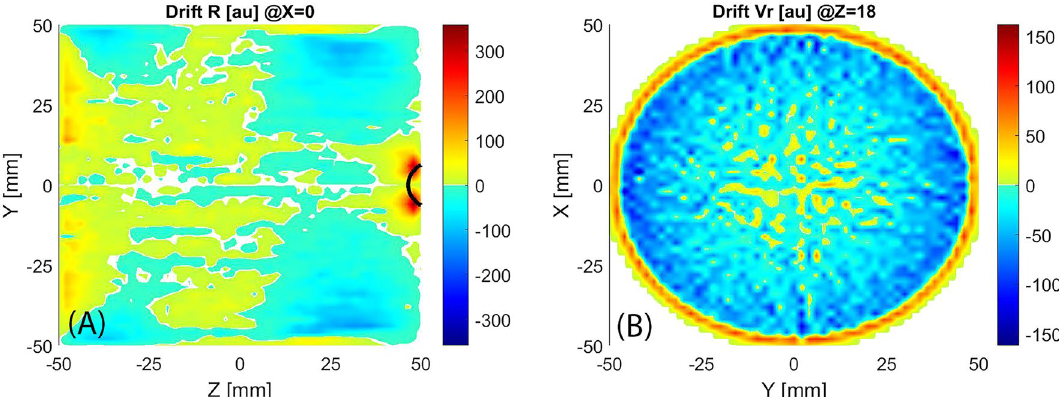
Figure 7. A longitudinal ( A ) and a transversal ( B ) slice of the radial drift velocity, black line highlights the ECR region.